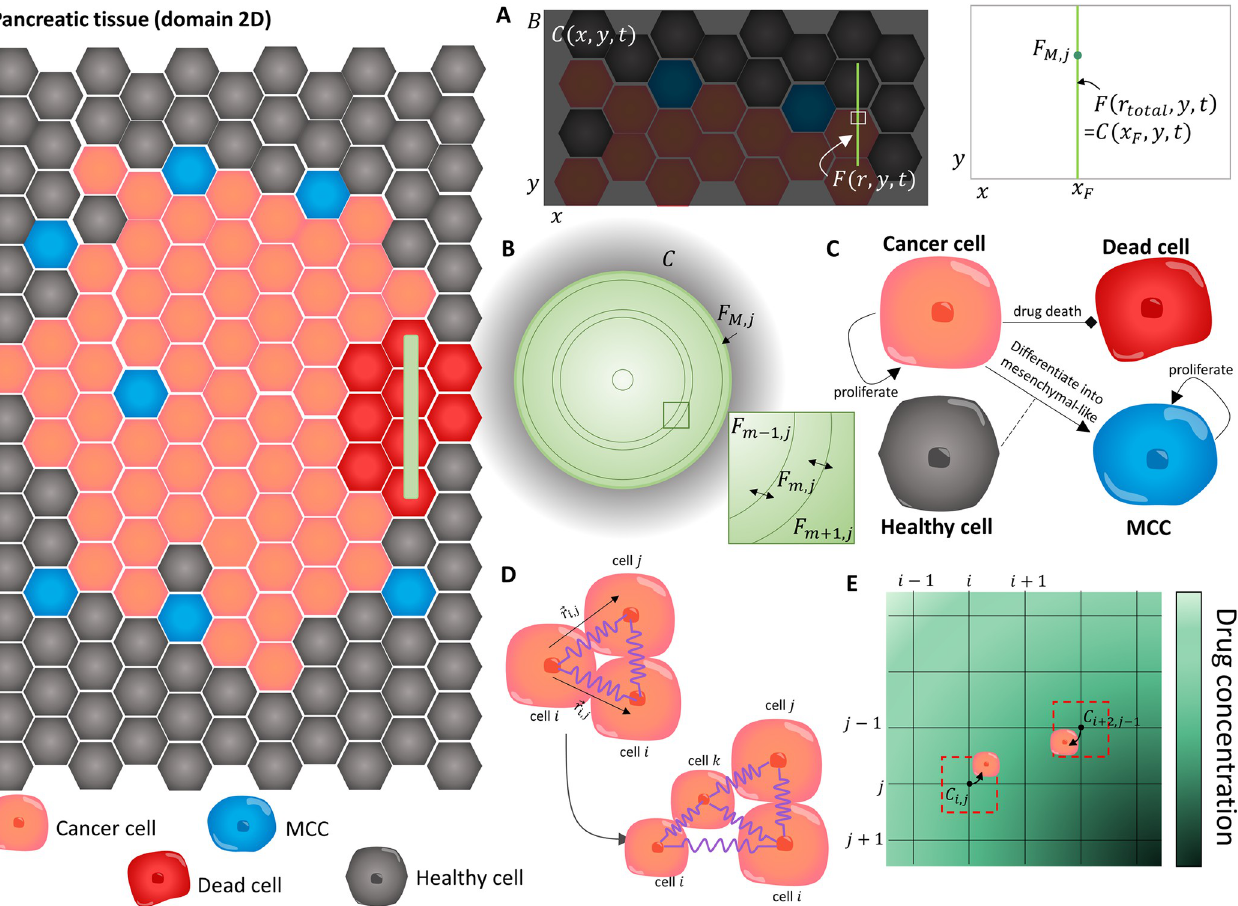
Fig 2. The main components of the VCBM–PDE model. In the VCBM, we model the interactions between healthy cells (grey), cancer cells (orange), MCC (blue) and dead cells (read) in a 2–dimensional tumour microenvironment cross section. (A) The concentration of drug in the TME was modelled in a 2 dimensional domain bounded by B , where C ( x , y , t )was the concentration in the TME at position ( x , y ). The fibre implant was then placed at a position x = x F and modelled as a line source. To capture the diffusion of drug from the fibre, we modelled the concentration of gemcitabine inside the fibre F ( r , y , t )at radial position r and domain position y where the continuity condition in Eq (3) required equal concentrations at the fibre boundary and at the immedicate local microenvironment, i.e. F ( r total , y , t ) = C ( x F , y , t ). (B) The concentration of gemcitabine inside the polymeric fibres was modelled by radially symmetric diffusion Eq (2) using a finite volume method (FVM) discretisation and considering the 2D cylindrical cross section of the fibres which have length L and radius r . total The fibre was discretised into concentric annuli F m , j at annulus m and cross section j , ( i = 0,1, ... , M ) and the concentration of drug in each annulus F m , j was modelled by considering drug diffusion across the bounadaries (e.g. F and F flow into F and vice vera). The full discretisation is presented in S1 m − 1, j m +1, j m , j Technical Supplementary Information . (C) Modelling assumptions for the VCBM were that cancer cells (orange) proliferate and some are able to cause epithelial to mesenchymal transtion and become invasive. We model this transition by assuming cells differentiate into a mesenchymal cancer cell (MCC) with one daughter cell placed on a neighbouring healthy cell. These MCCs cause the break down of surrounding tissue (i.e. replace healthy neighbouring cells with their progeny). Cancer cells can then die through gemcitabine uptake from their local environment. For more details see Fig B in S1 Text . (D) Individual cells were modelled as cell centres connected by springs [57]. The proliferation of a cell introduced a new cell into the lattice network which caused the rearrangement of the cells in the lattice with movement governed by Hooke’s law. (E) To simulate the gemcitabine concentration in the TME, Eq (1) , we introduced a FVM discretisation, where the gemcitabine concentration was defined at discrete volumes centered around points in the discretisation. Cells could take up drug from the nearest grid point to their centre, and this concentration was used to determine their likelihood of drug–induced cell–death.